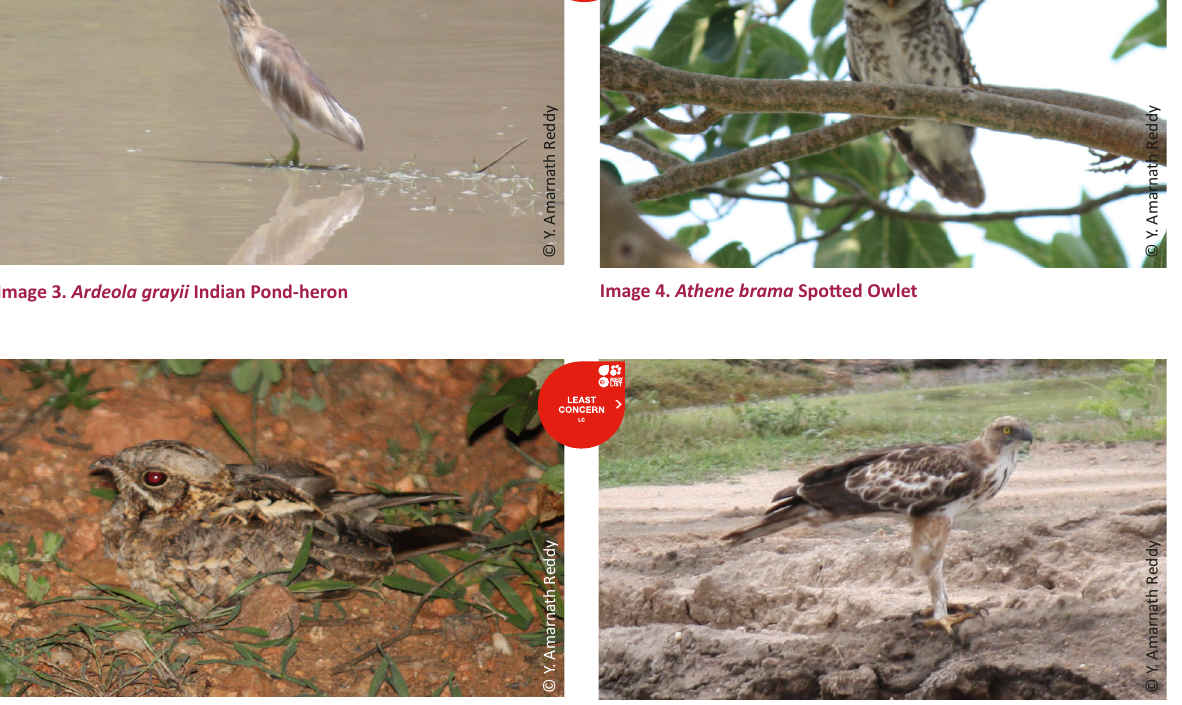
Image 6. Circus aeruginosus Western Marsh Harrier